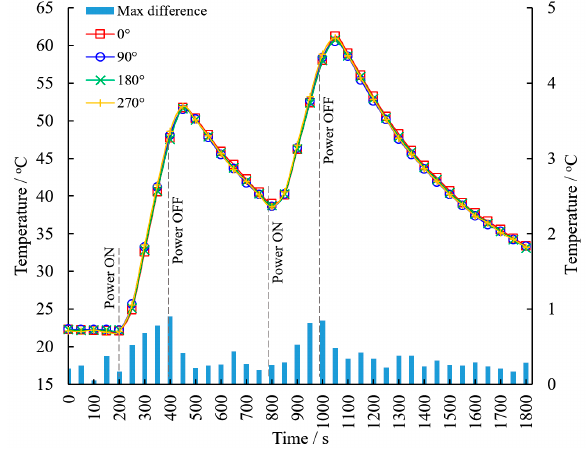
Figure 7. Temperature distribution along the circumference on the surface.